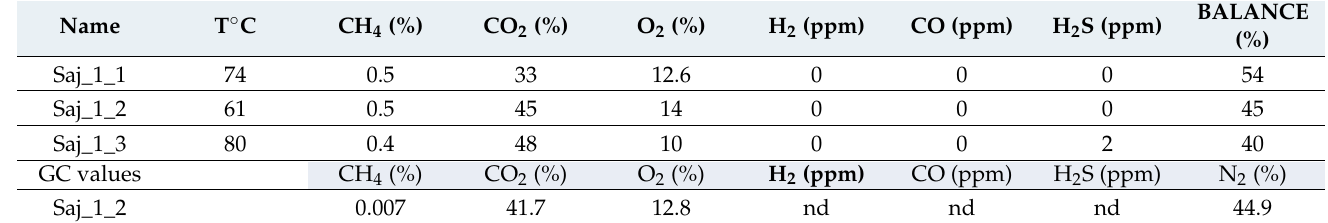
Table 4. Field and GC values in the Sajama